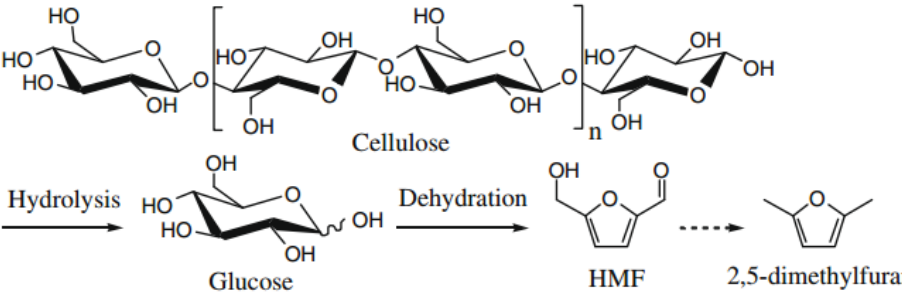
Figure 10. Schematic illustration of the steps for cellulose to HMF [148]. Copyright Elsevier, 2009.